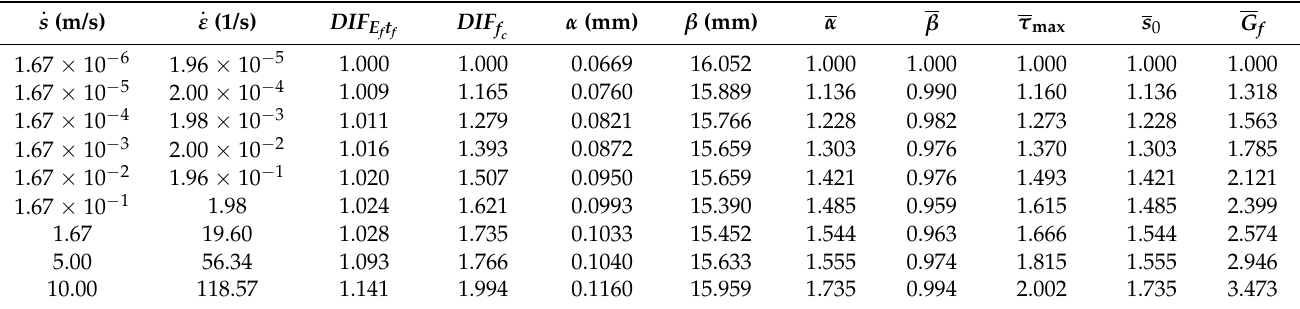
Table 6. Calculation results under different slip rates.